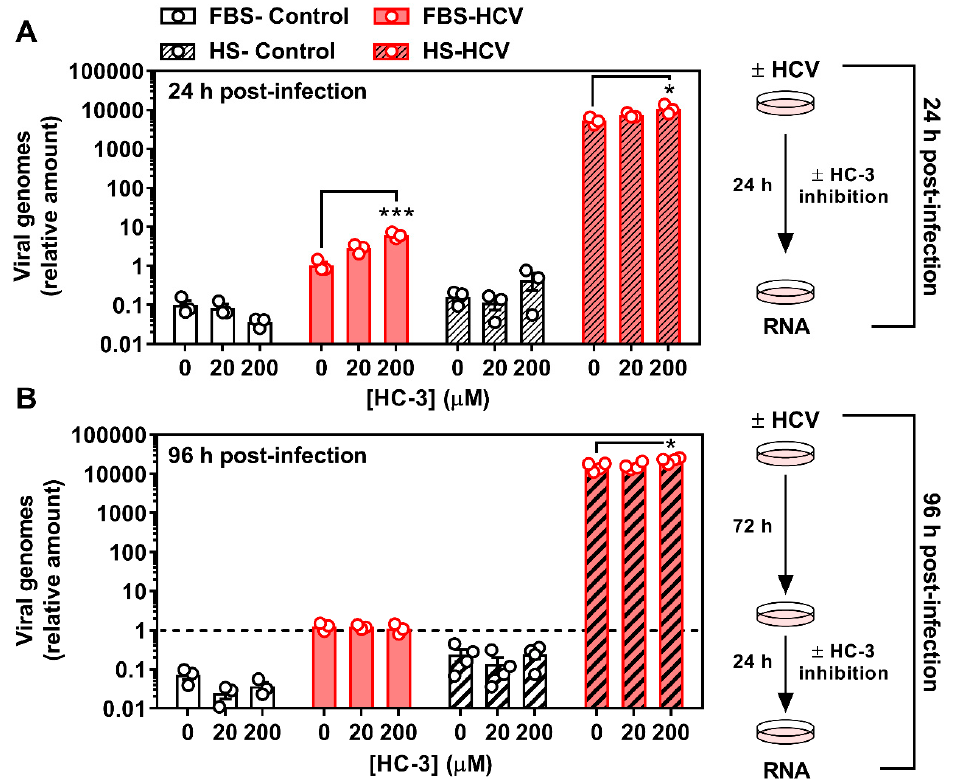
Figure 5. Inhibition of choline uptake augments HCV replication after 24 h. FBS- and HS-cultured Huh7.5 cells were infected at an MOI of 1 for ( A ) 24 h in the presence or absence of 20 or 200 µM hemicholinium-3 (HC-3) to inhibit choline uptake and ( B ) 96 h in the presence or absence of 20 or 200 µM HC-3 for the last 24 h of infection. Cells were washed and RNA was isolated to assess HCV RNA expression as an indication of viral replication. All treatments are shown relative to infected vehicle FBS-control cells and normalized to the average of β ACTIN and HSP90 . Data are mean±SEM and are represent of 3-4 independent experiments. The hashed line in ( B ) represents the level of infected FBS- HCV group, such that 0, 20 and 200 µM HC-3 from FBS- and HS-cultured cells were each